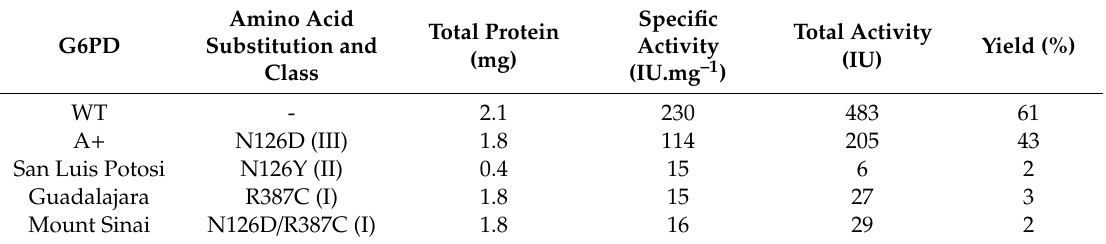
Roman numerals indicate variant